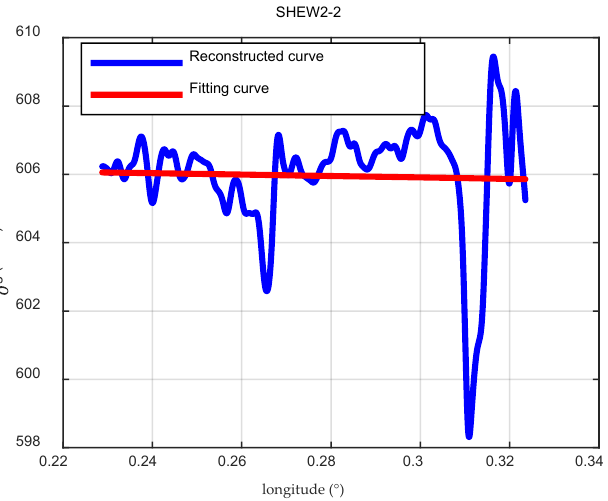
Figure 4. Fitting curve of gravity-measurement results of survey line SHEW2-2.